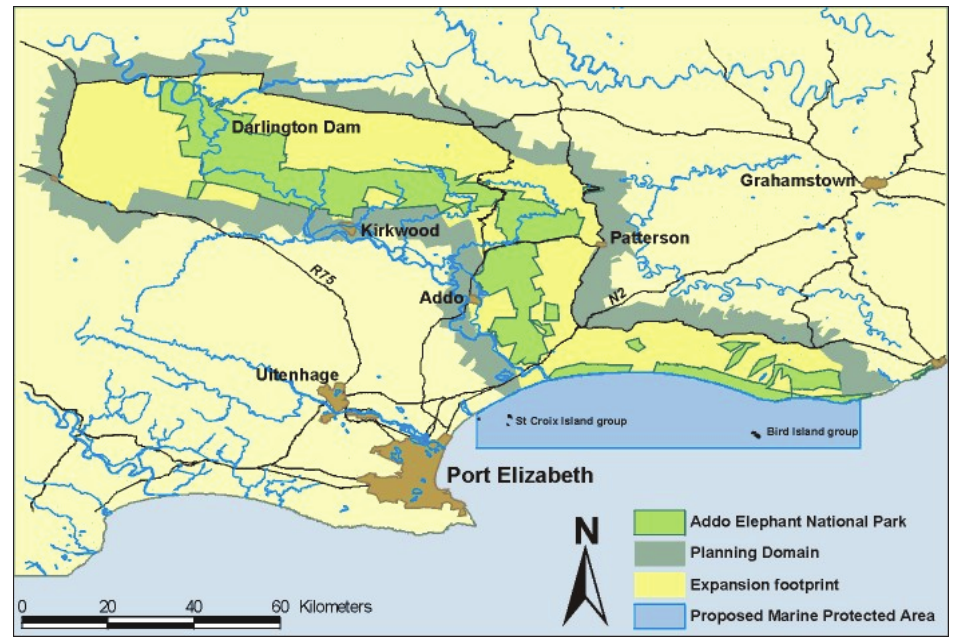
Fig. 1. Extent of the gAENP planning domain (CES